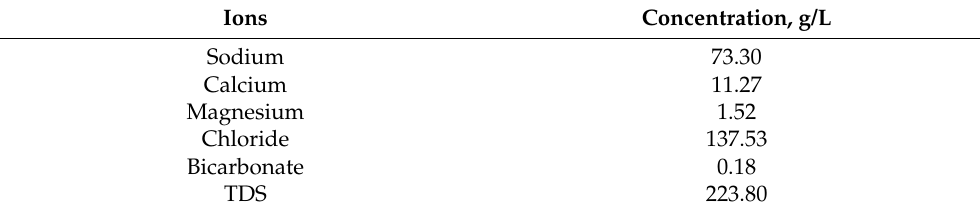
Table 4. Ionic composition of synthetic water of Tahe